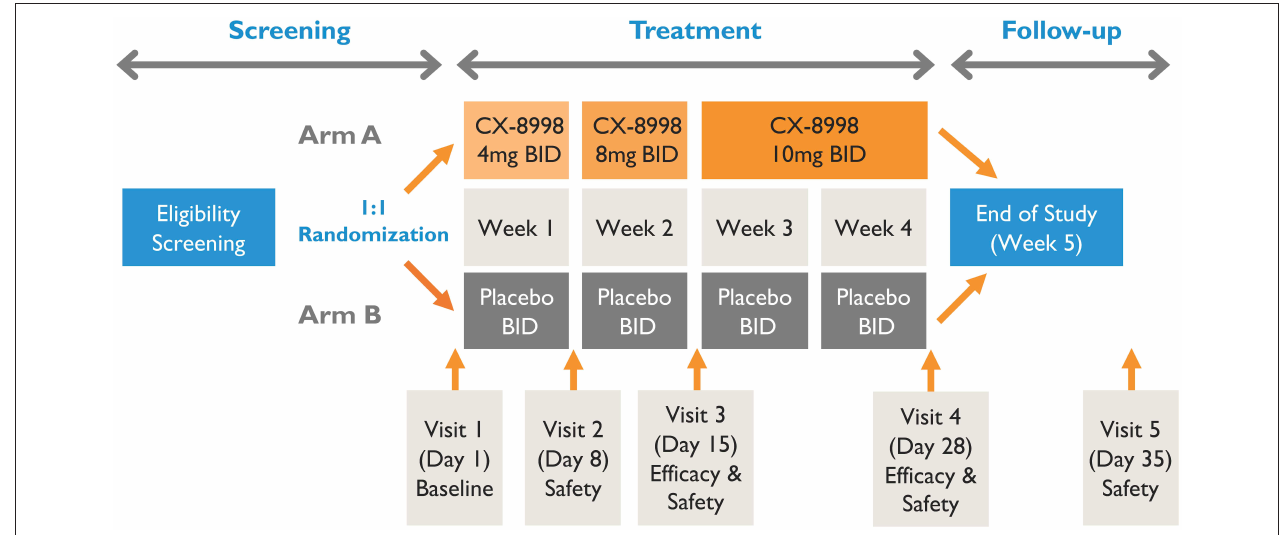
FIGURE 1 | Schematic of T-CALM